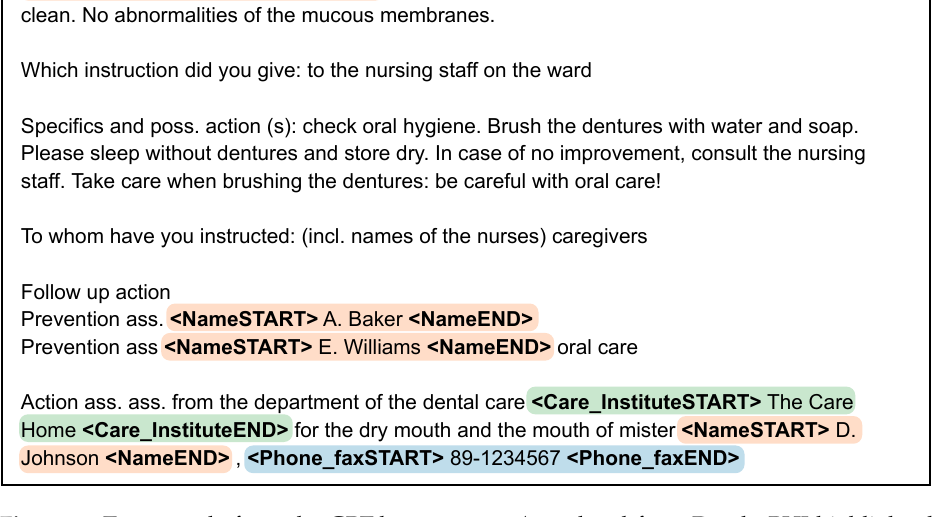
Figure 6. Text sample from the GPT-beam corpus (translated from Dutch, PHI highlighted and replaced with random identifiers). The structure of the generated text resembles a template that nurses used in the real data to report on dental hygiene of a